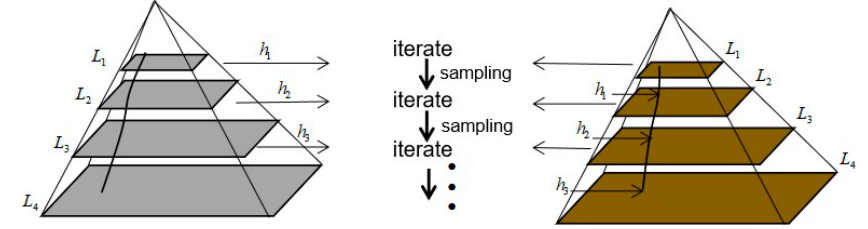
Figure 2. Pyramid LK algorithm.